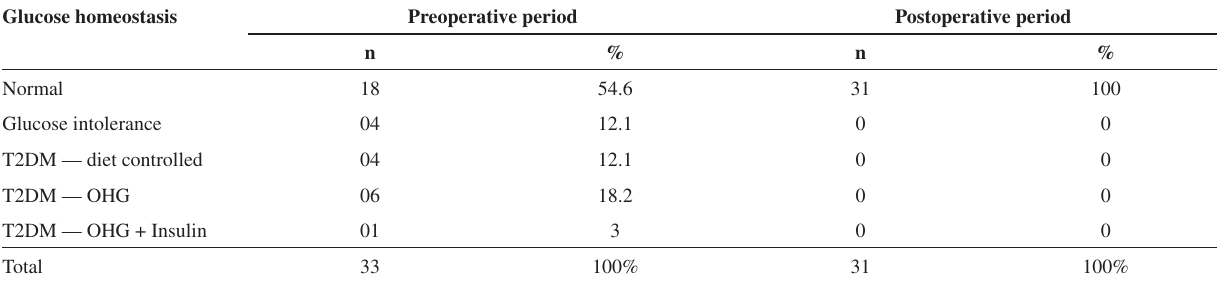
Table 1 - Glucose homeostasis and oral hyperglycemic agent/insulin use before and after SRSG Glucose homeostasis Preoperative period Postoperative